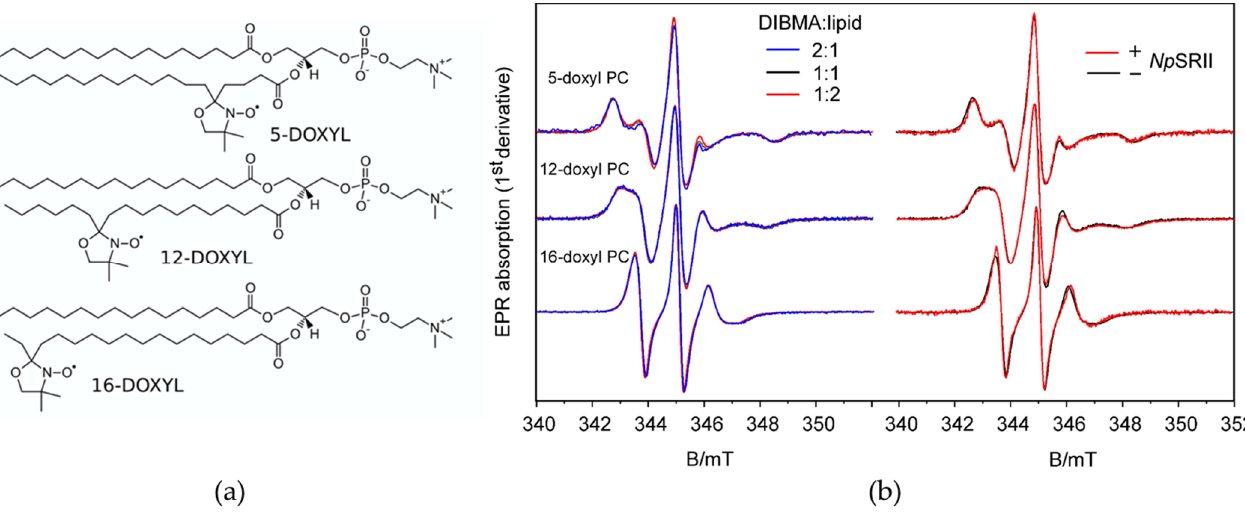
Figure 4. The dynamics of spin labeled lipids enclosed in DIBMALPs of different sizes and in absence and presence of Np SRII. ( a ) Doxyl-PCs with nitroxides bound at the 5th, 12th and 16th carbon position of the hydrocarbon chain. ( b ) EPR spectra recorded at room temperature for DIBMALPS prepared (left panel) with different DIBMA-to-lipid ratios ( w / w ), 2:1 (blue), 1:1 (black) and 1:2 (red), and (right panel) in presence (red) and absence (black) of Np SRII at a 1:1 ( w / w ) DIBMA-to-lipid ratio.